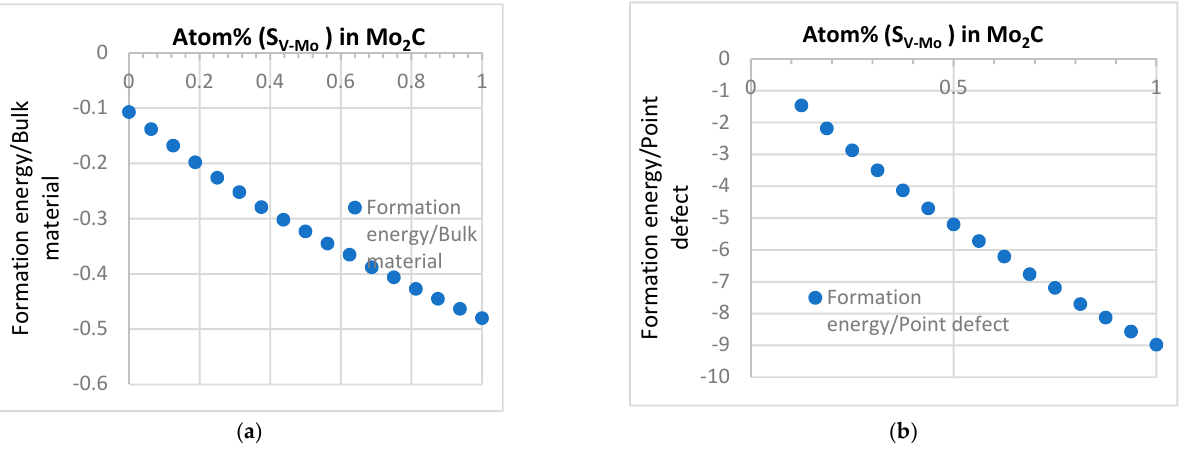
Figure 8. The bulk formation energy and the formation energy of defect with different S V-Mo concen- tration. ( a ) Formation energy. ( b ) Formation energy of defect.